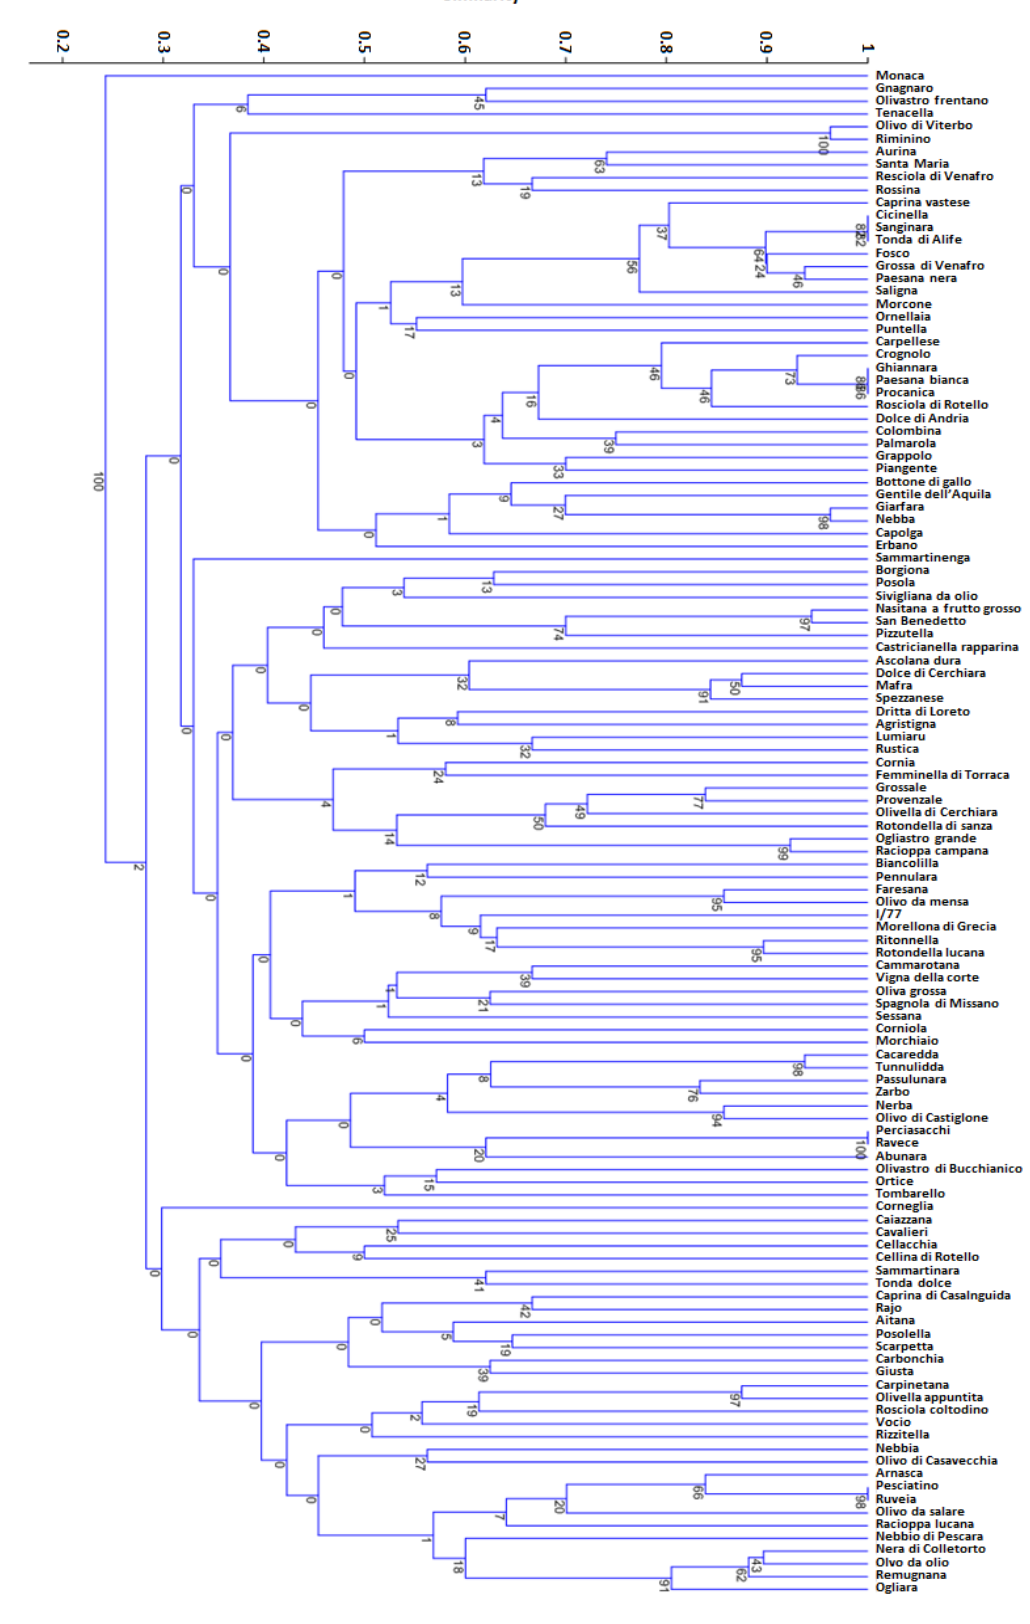
Figure 5. Dendrogram of relationships among the 120 olive varieties.